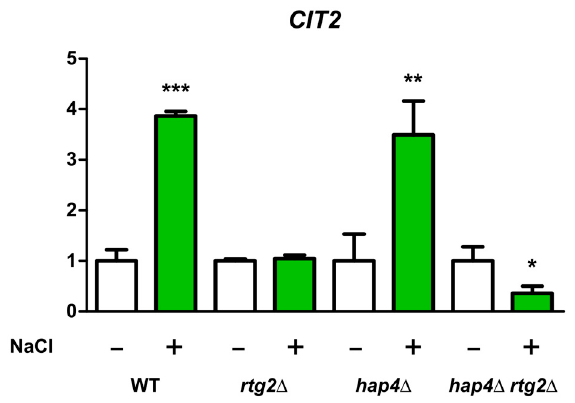
Figure 4. CIT2 expression under high osmotic environment. Wild type (WT) and mutant cells (hap4 ∆ , rtg2 ∆ , hap4 ∆ rtg2 ∆ ) grown overnight in YPD medium were diluted to 0.1 OD 600 in fresh liquid YPD with or without 0.8 M sodium chloride (NaCl). After 5 h, cells were collected for RNA extraction, mRNA levels were measured by quantitative PCR, and the cells grown without NaCl stress were used as calibrator. The relative amount of CIT2 mRNA was calculated according to the comparative method (2 − ∆∆ Ct ). Values are mean ± SD of three independent experiments. Unpaired Student’s t -test: a statistically significantly difference with *** p < 0.0001; ** p < 0.01; * p < 0.05 when comparing untreated cells versus NaCl-stressed